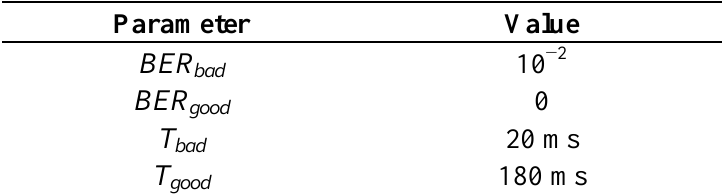
Table 2. Parameters of the Gilbert-Elliot